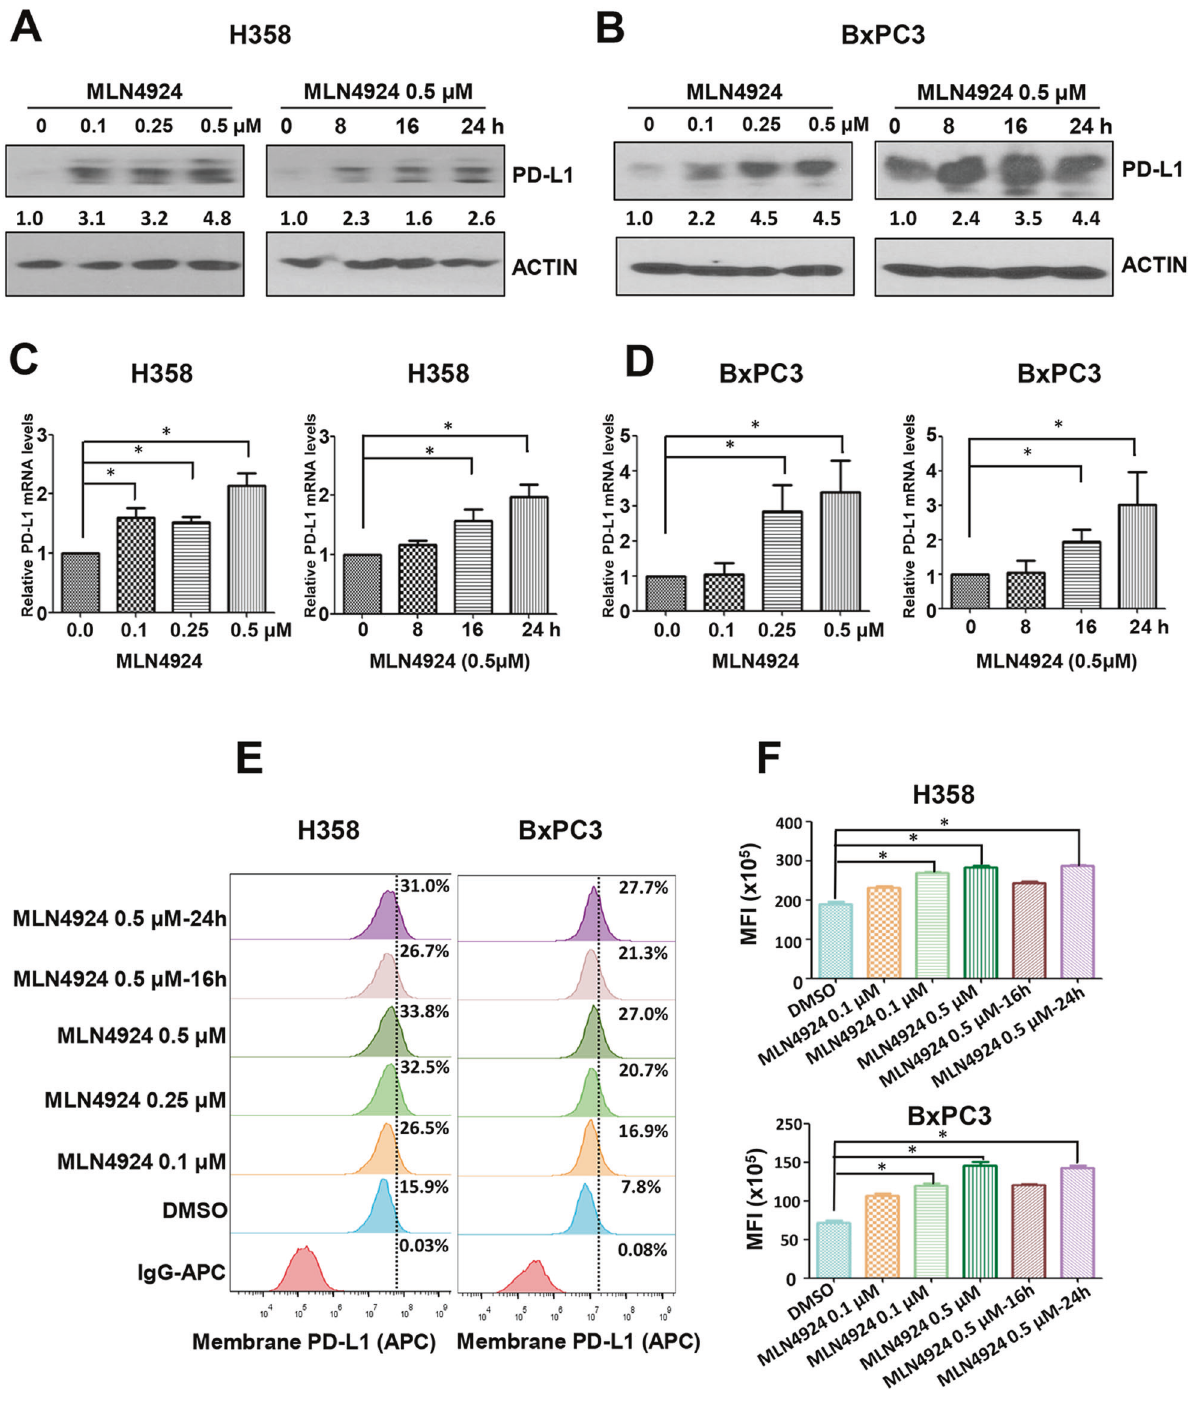
Fig. 1 MLN4924 increases PD-L1 expression at both mRNA and protein levels in dose- and time-dependent manners. A – D MLN4924 treatment increases PD-L1 protein levels and mRNA levels in dose- and time-dependent manners. H358 and BxPC3 Cells were treated with various concentrations of MLN4924 for the indicated time periods, followed by IB with the indicated Abs ( A , B ), or followed by qRT-PCR analysis ( C , D ). E , F MLN4924 treatment increases the cell surface PD-L1 levels in dose- and time-dependent manners. H358 and BxPC3 Cells were treated with various concentrations of MLN4924 for the indicated time periods, followed by FACS analysis. MFI Median Fluorescence Intensity; p < 0.05 function of T cells, and performed a co-culture assay of the Jurkat MLN4924 attenuates cytotoxic effect of Jurkat T cells through T cells with cancer cells with or without MLN4924 pretreatment PD-L1 induction (Figs. 4A and S5A, top panel). As expected, cancer cells with To understand the potential biological consequence of PD-L1 MLN4924-pretreatment had a higher PD-L1 expression. Interest- upregulation by MLN4924, we asked whether MLN4924 induction ingly, Jurkat cells co-cultured with MLN4924-pretreated cancer of PD-L1 in cancer cells would negatively affect the viability and